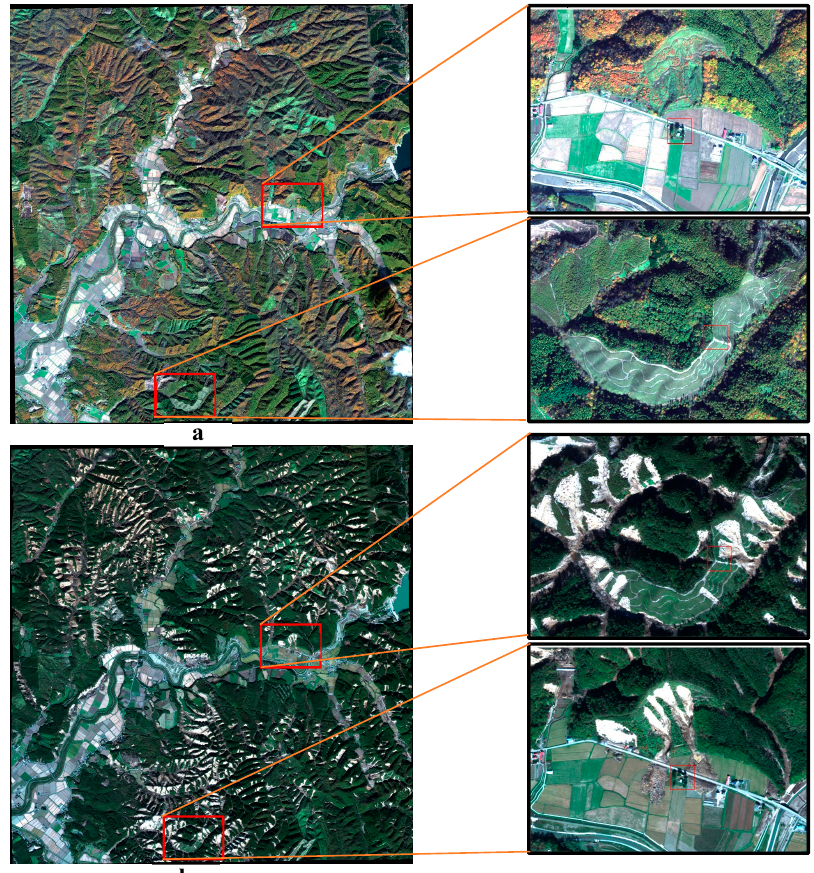
Figure 4. The orthorectified image from WorldView-2 (left) on 24 October 2017( a ) and from GeoEye-1 (right) on 20 October 2018 ( b ); right Figures are the enlarged views of red rectangles in ( a ) and ( b ), respectively.